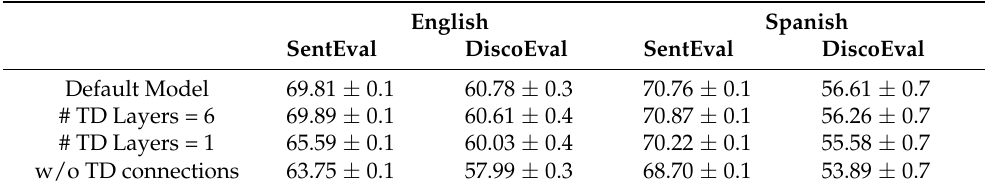
Table 3. Results of ablation study in SentEval and DiscoEval. PredALBERT-R, both in English and Spanish, was used as the default